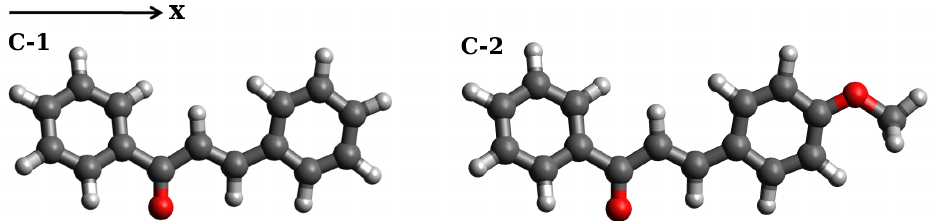
Figure 1. The structures of the C-1 and C-2 molecules studied in the present work. Shown is also their orientation in the Cartesian coordinate system adopted for second-order transition moment calculations (see the text for